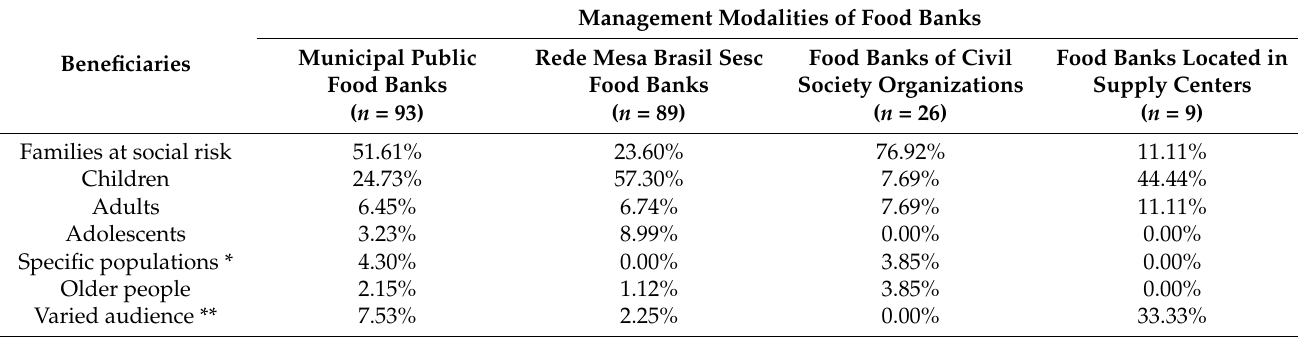
Table 3. Main beneficiaries of the Brazilian food banks, according to management modality, in 2019 ( n = 217).